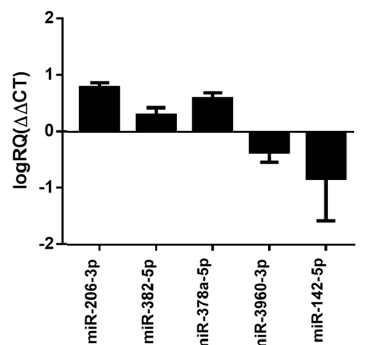
Figure 3. Validation of the next-generation sequencing (NGS) results of the HPC tumor model by qPCR analysis. The results were each microRNA of 188 Re-liposome-treated HPC normalized to that of untreated controls.